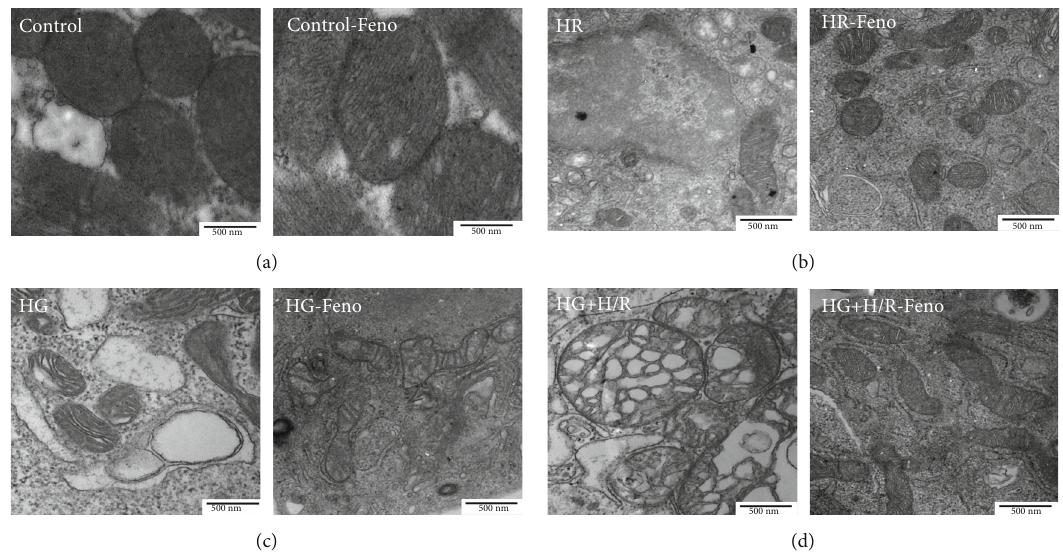
Figure 10: Feno fi brate (10 μ M) attenuates damage to the mitochondrial ultrastructure in primary cultures of cardiomyocytes subjected to hypoxia/reperfusion (H/R), high glucose (HG), and HG+H/R. Details of the ultrastructure by electron microscopy: 500 nm, 50,000x. (a) Control-DMSO and control/feno fi brate, (b) H/R-DMSO and H/R-feno fi brate, (c) HG-DMSO and HG-feno fi brate, and (d) HG+H/R- DMSO and HG+H/R-feno fi brate. The images are representative of 6 experiments per